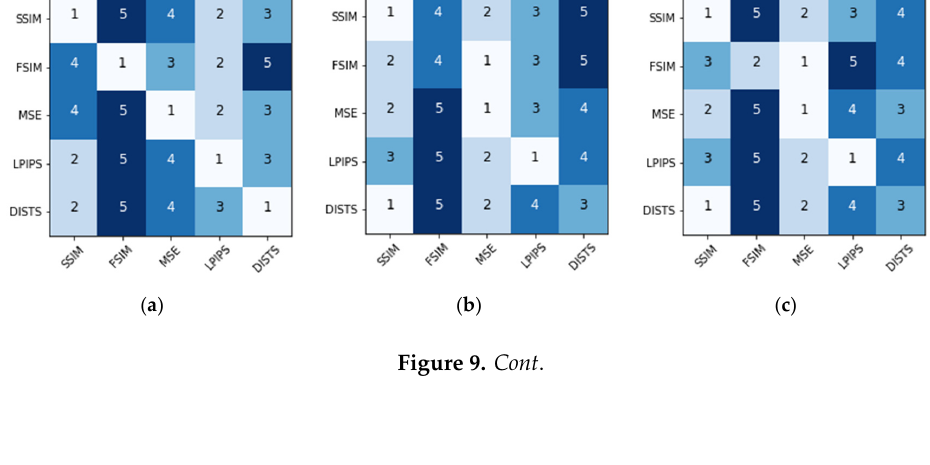
Figure 8. Convergence curves of the whole iterations in Gorge restoration based on different IQA models. ( a ) SSIM; ( b ) FSIM; ( c ) MSE; ( d ) LPIPS; ( e ) DISTS.